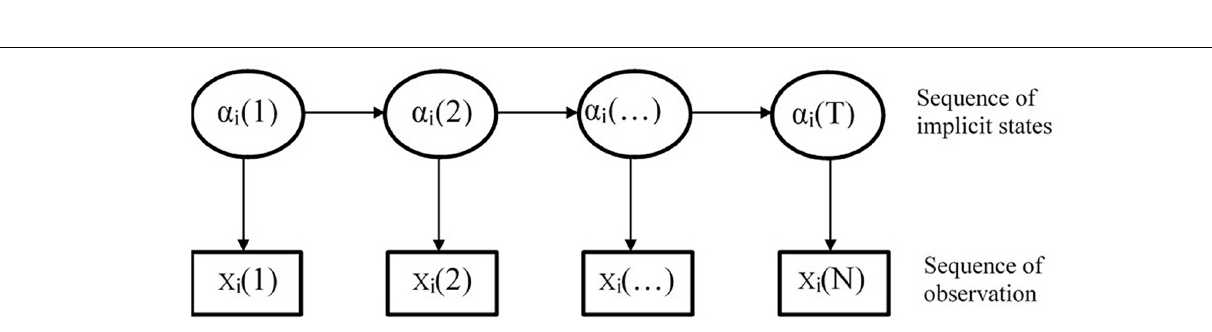
FIGURE 1 | Basic structure of self-organizing map and supervised self-organizing map, respectively.